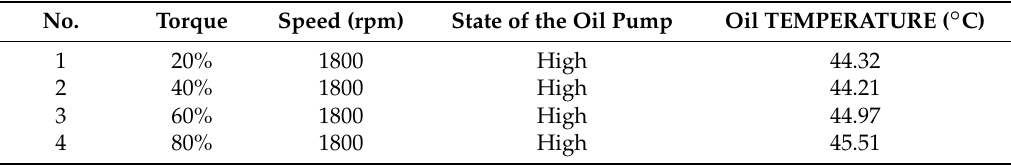
Figure 16. The variation of the electrostatic signal with torque.